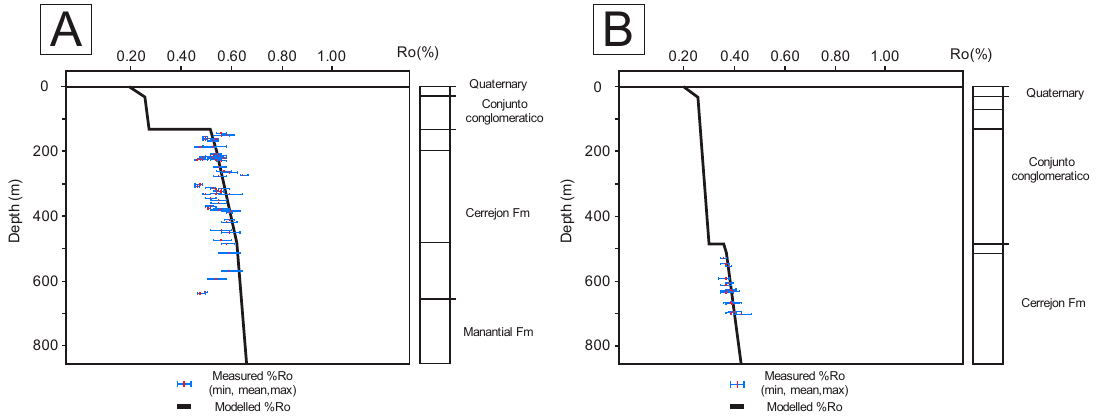
Figure 17. Calibration of vitrinite reflectance (%Ro) with depth for the ( A ) ANH-CARRETALITO-1 and ( B ) ANH-CAÑABOBA-1 wells.